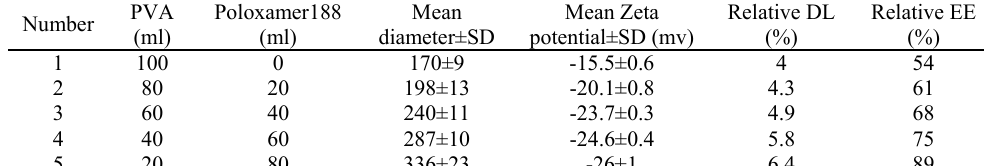
Table 1. A brief view of the properties of nanoparticles.